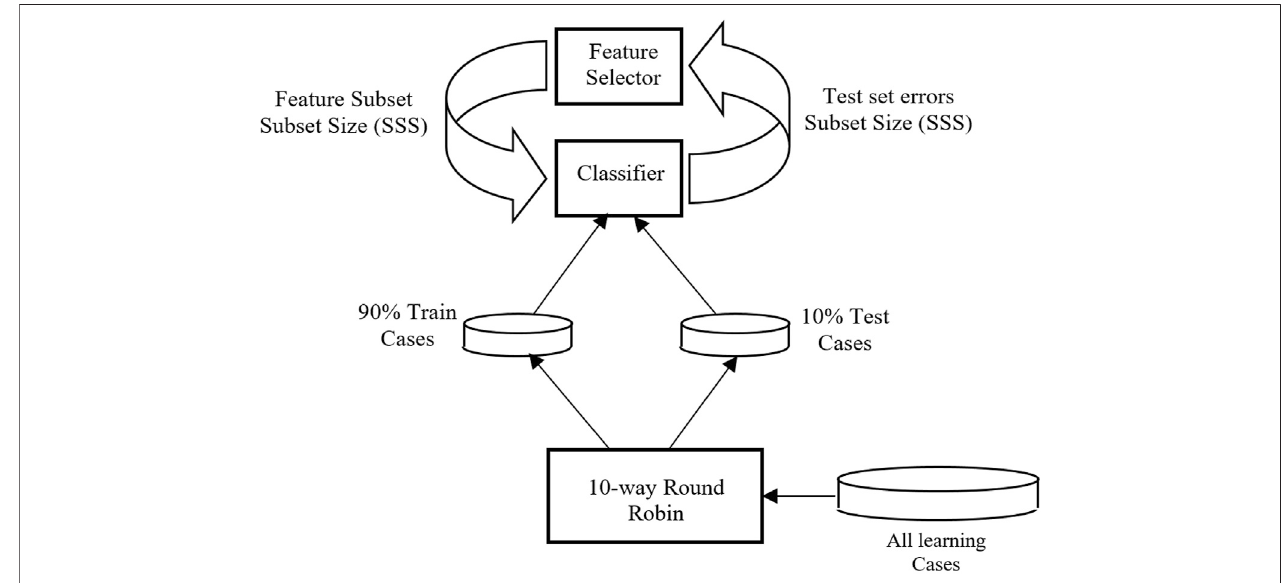
FIGURE 5 | Overview of classi fi er to determine AD/NL decision.